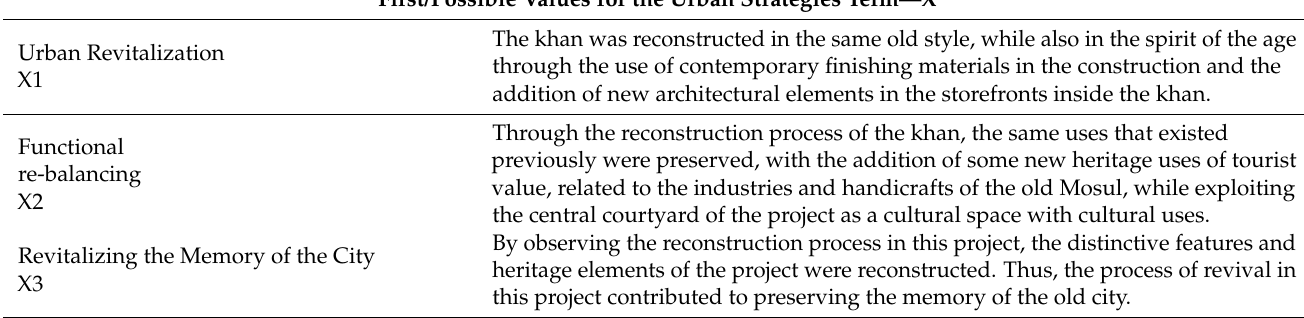
Table 2. Specialized description form for measuring the verification values of the variables of strategies for reviving urban heritage after